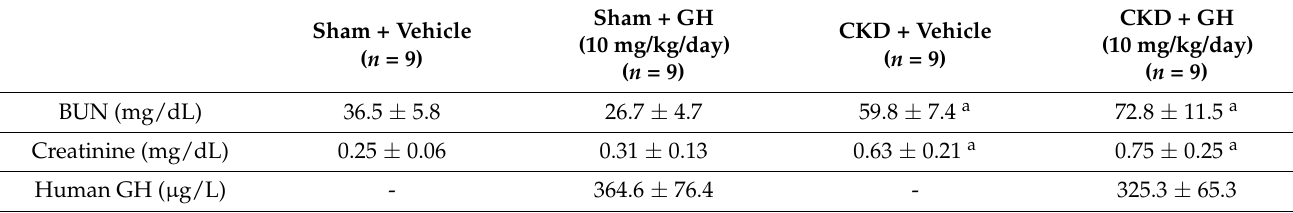
Table 2. Serum and blood chemistry in mice from diet-restrictive study. Eight-week-old CKD and sham mice were treated with GH (10 mg/kg per day), or normal saline as a vehicle for six weeks. CKD mice were fed ad libitum. The other mouse groups received an energy intake amount equal to that of CKD + Vehicle mice. BUN, blood urea nitrogen. Results are analyzed and presented as in Table 1. a p < 0.05, significantly higher than Sham + Vehicle